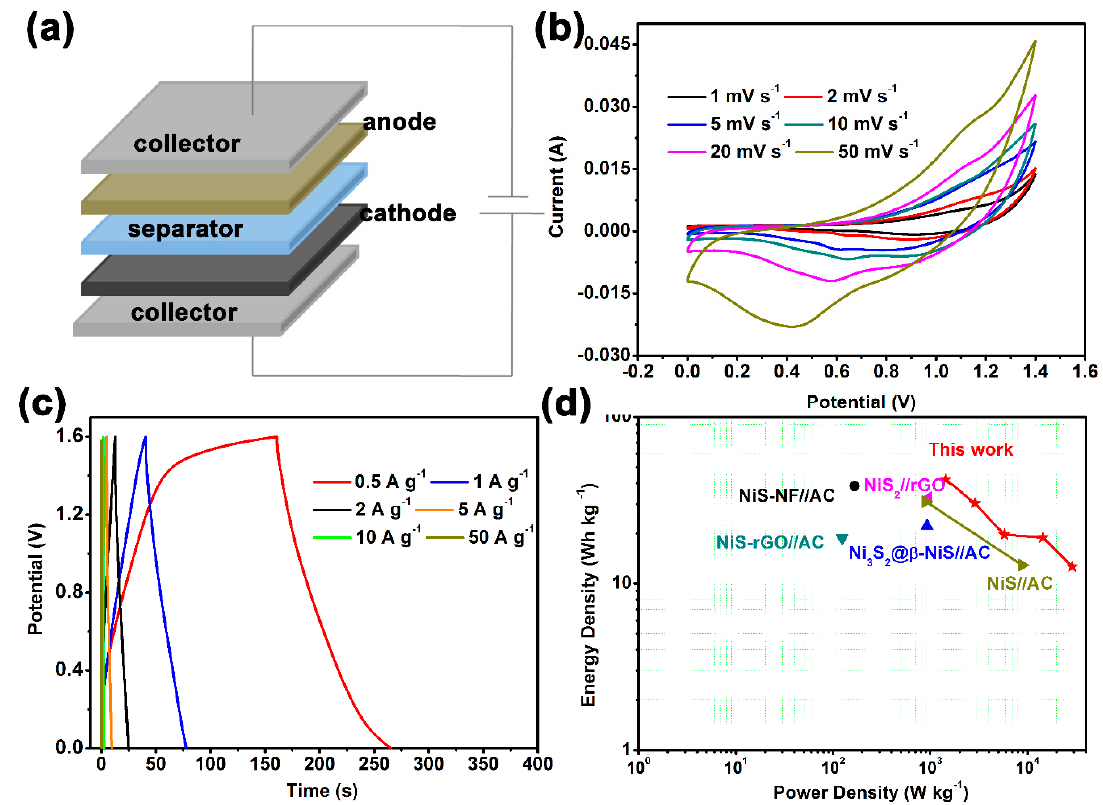
Figure 5. Electrochemical performances of the flower-like β -NiS//active carbon hybrid asymmetric supercapacitor: ( a ) schematic illustration of the asymmetric supercapacitor configuration, ( b ) CV curves at different scan rates, ( c ) GCD curves at various current densities, and ( d ) the Ragone plots.